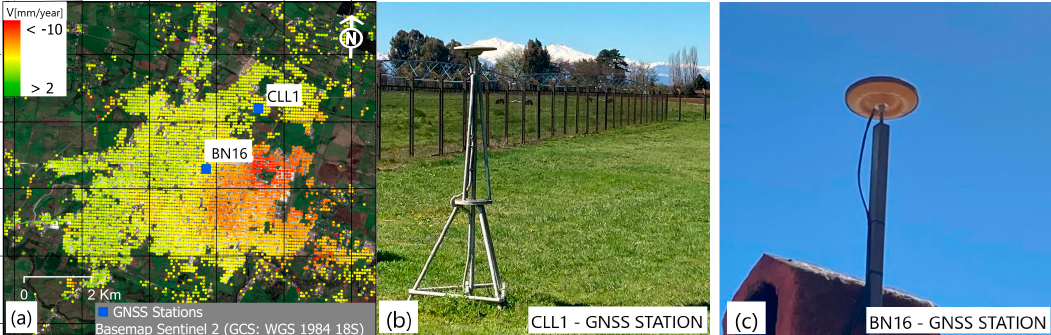
Figure 4. ( a ) Location GNSS stations in the study area, ( b ) CLL1 GPS, and ( c ) BNL16 GPS devices.